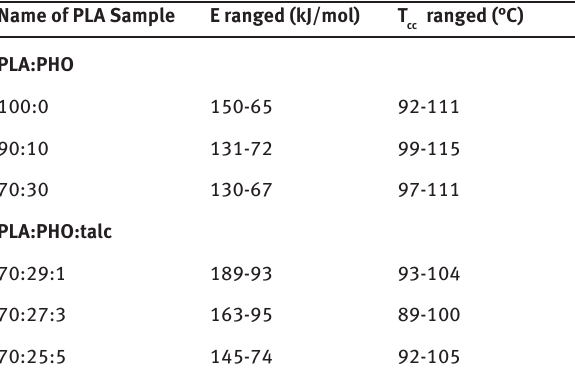
and E by KAS method for neat PLA and its cc